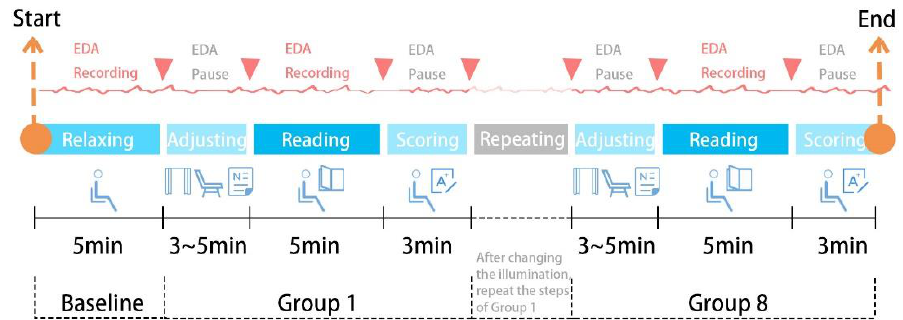
Figure 8. Experimental process.